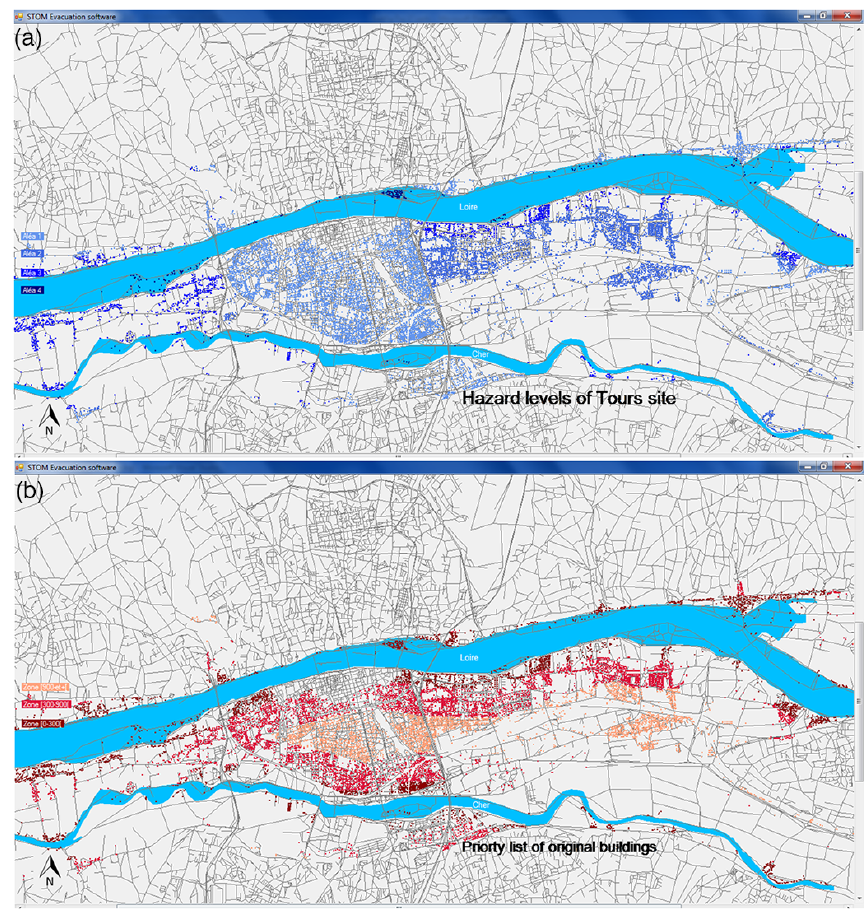
Figure 9. The preliminary steps for the construction of evacuation plan I: (a) shows the hazard levels while (b) illustrates the destruction zones and the assignment of priority to